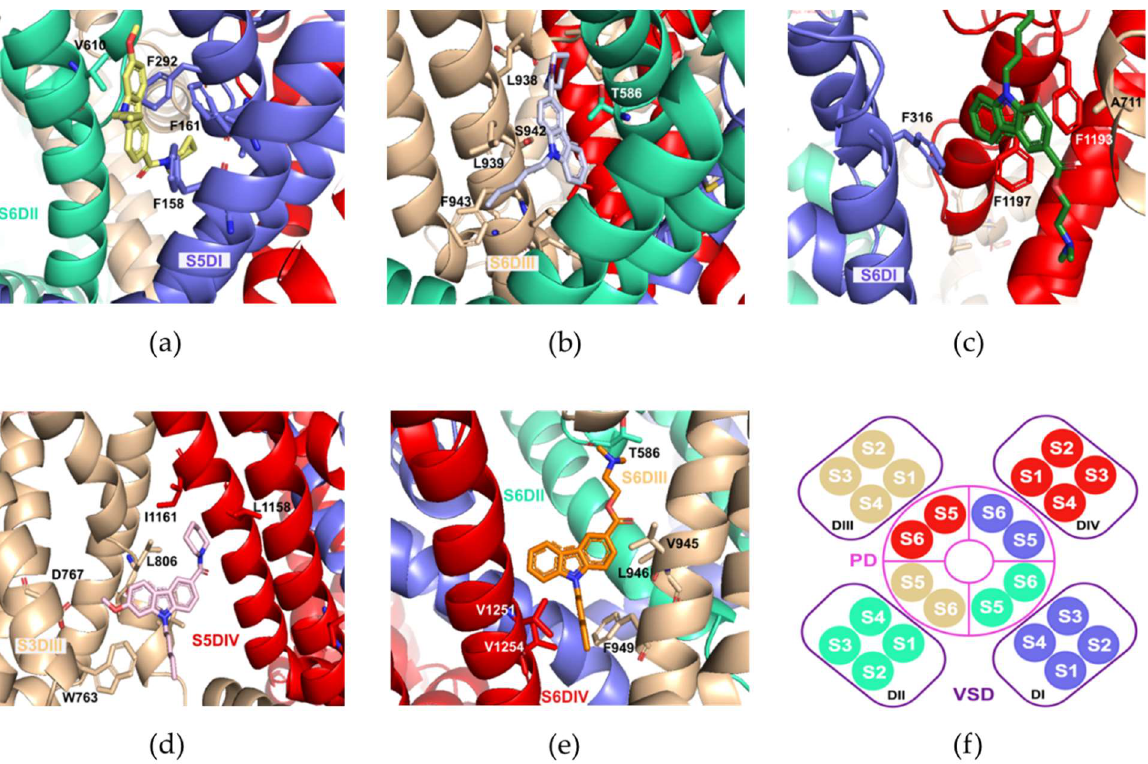
Figure 7. Important interaction residues of the NMP compounds with the Ca v 3.2 channel, ( a ) NMP-4 in the S6DII site, ( b ) NMP-7 in the S6DIII site, ( c ) NMP-181 in the S6-DIII site, ( d ) NMP-4 in the S5DIV site, and ( e ) NMP-181 in the Pore-blocking site. In ( f ), extracellular view diagram as a reference showing the distribution of the transmembrane segments of the Ca v 3.2 channel situated in the Pore Domain (PD) and in the Voltage Sensing Domain